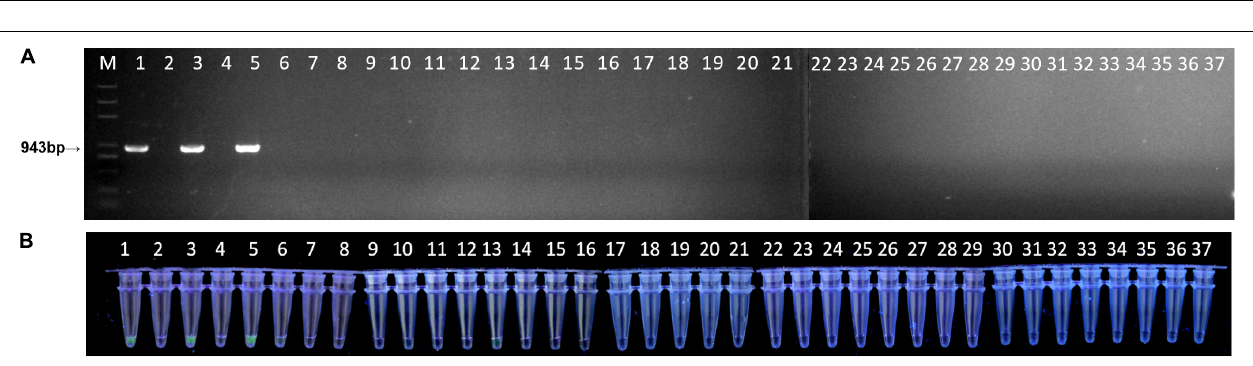
FIGURE 5 | Field evaluation of the RPA/Cas12a-fluorescence assay. (A) Schematic of the integrated RPA/Cas12a analysis. (B) The RPA/Cas12a-fluorescence detection of inoculated leaves. (C) The RPA/Cas12a-fluorescence detection of natural leaves. BC, blank control.